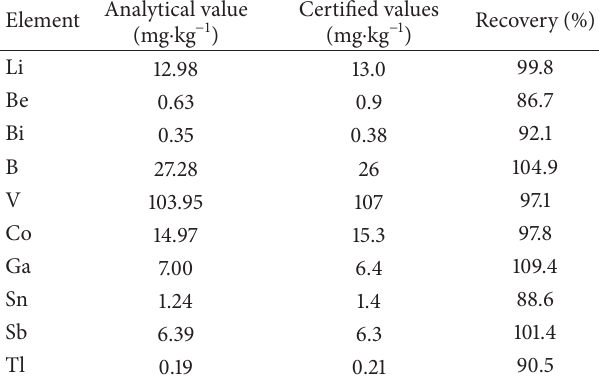
Table 1: GSD-12 certified values, analytical values, and recovery.